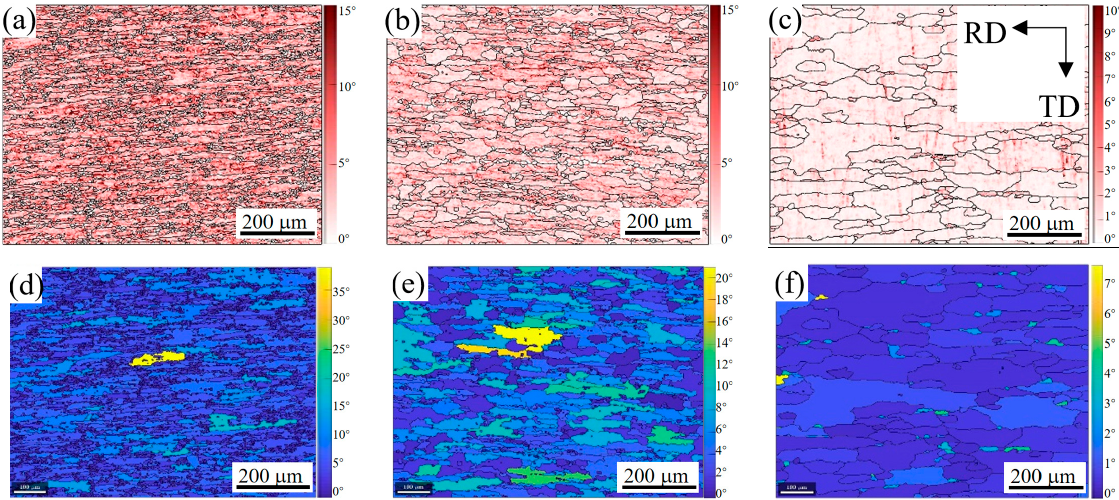
Figure 6. Kernel average misorientation results of the 2A14 Al alloy on the RD-TD plane after annealing to ( a ) 505 °C, ( b ) 555 °C, and ( c ) 580 °C. Grain orientation spread maps of the 2A14 Al alloy on the RD-TD plane after annealing to ( d ) 505 °C, ( e ) 555 °C, and ( f ) 580 °C.